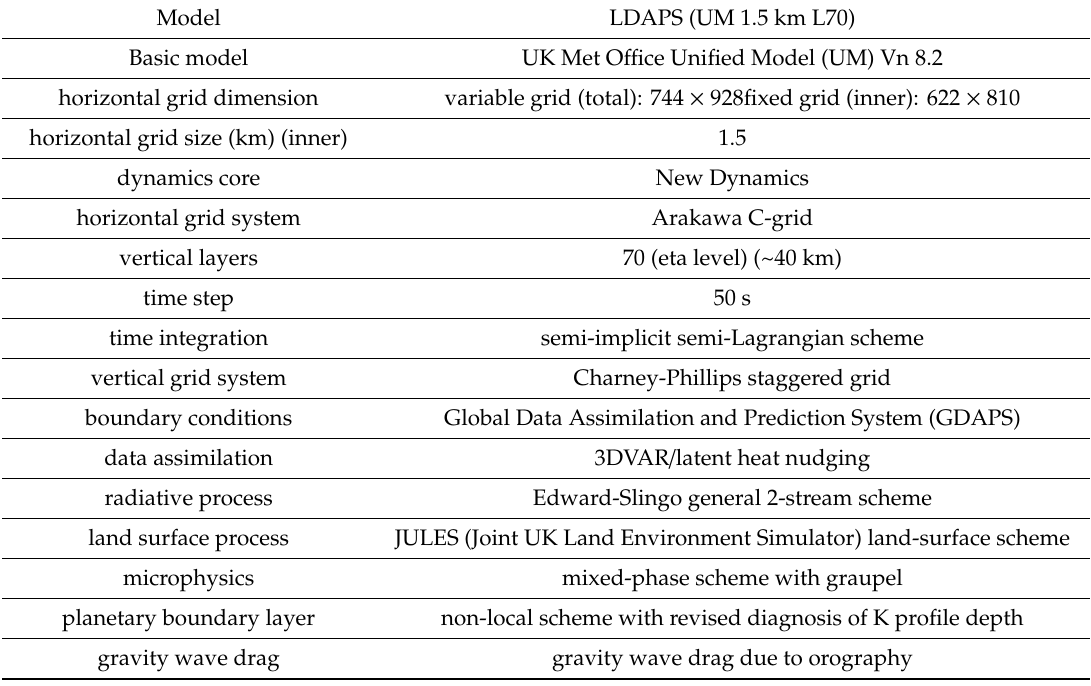
Table 1. Summary of local data assimilation and prediction system (LDAPS)’s numerical